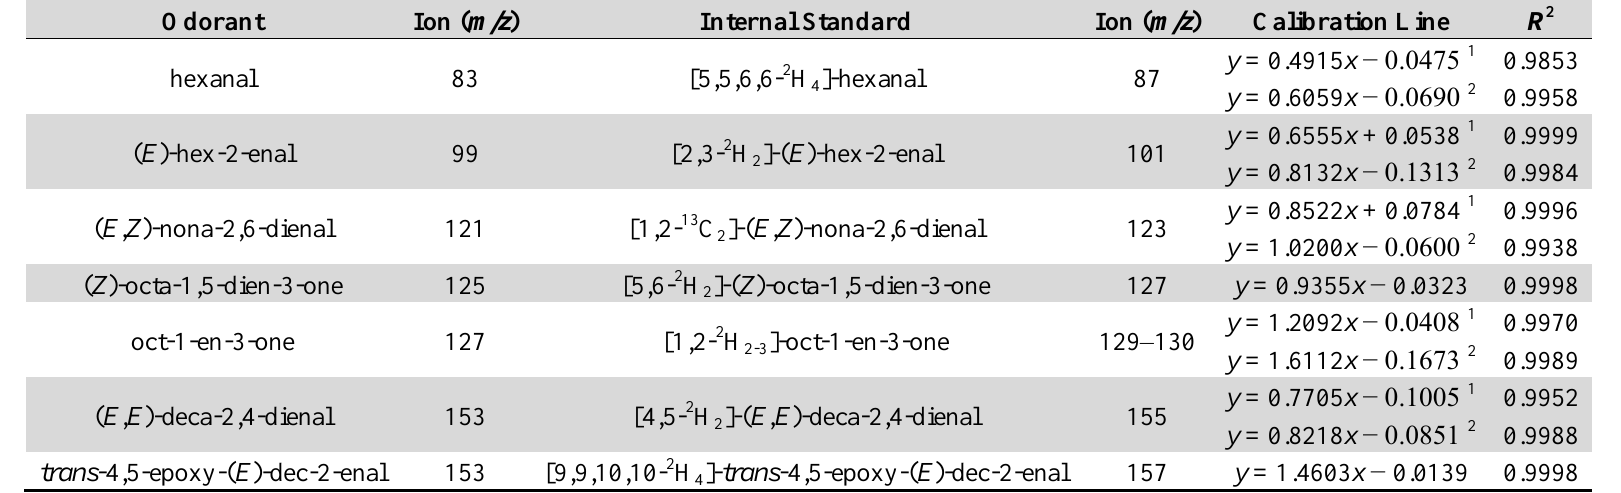
Table 2. Odorants, selected ions for quantification by stable isotope dilution assays and details on calibration factors determined on film capillary DB-5. R 2 —coefficient of